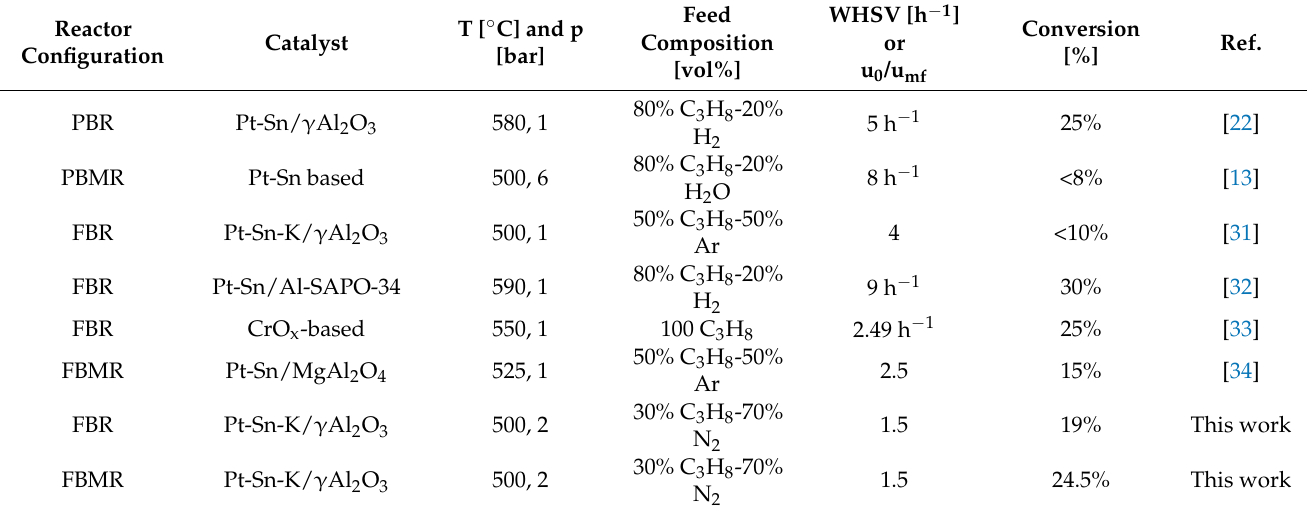
Table 4. Experimental values of minimum fluidization velocity as function of temperature.